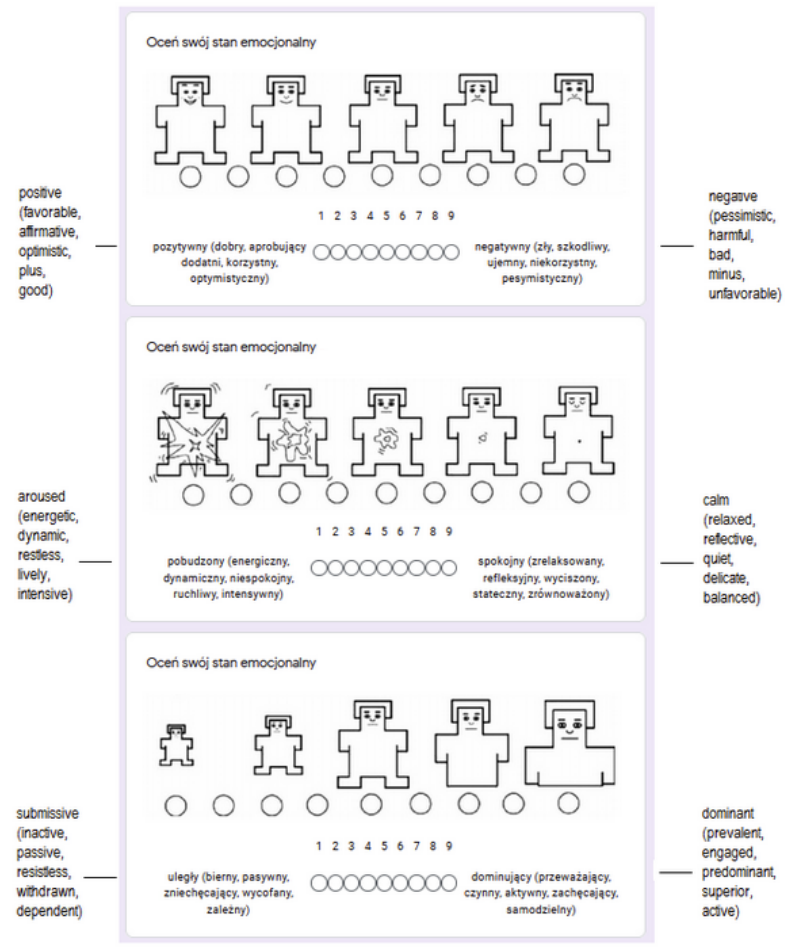
Figure 1. Emotional state self-assessment scale—a screenshot with adjective